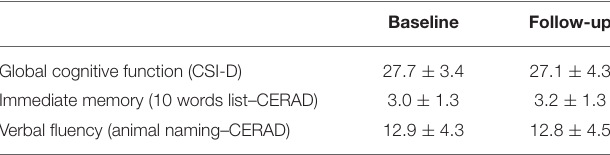
TABLE 2 | Mean and standard deviation of the cognitive performance of the participants at baseline and follow-up ( n = 1,243).